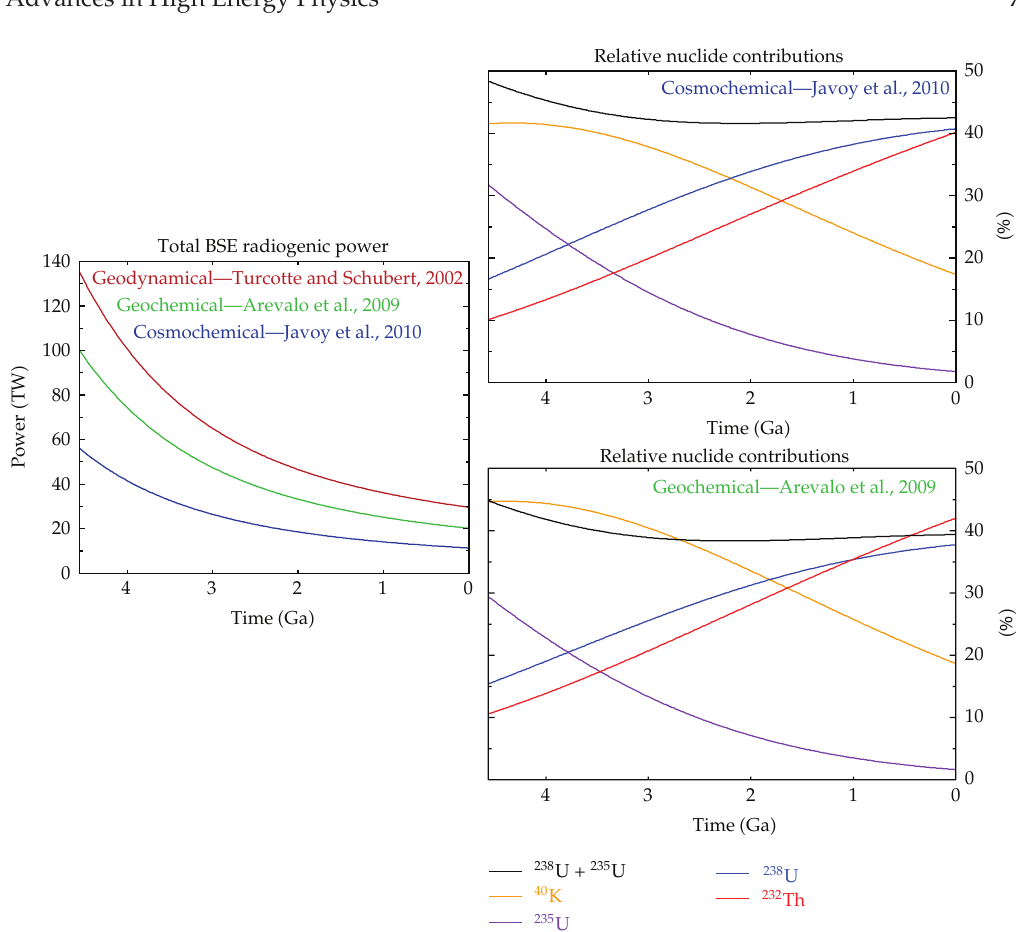
Figure 2: (cid:5) left (cid:6) Total radiogenic power over Earth’s history as predicted by cosmochemical, geochemical, and geodynamical BSE estimates. (cid:5) right (cid:6) Relative contributions of each radionuclide for cosmochemical (cid:5) top (cid:6) and geochemical (cid:5) bottom (cid:6)